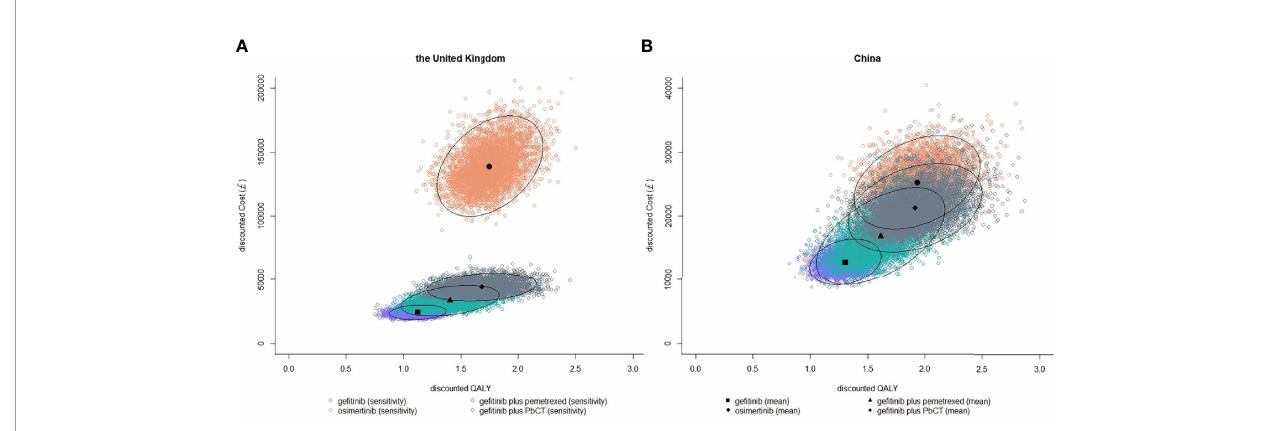
FIGURE 3 | Probabilistic scatter plots of costs and QLAYs of ge fi tinib, ge fi tinib plus pemetrexed based chemotherapy, and osimertinib for a cohort of 5000 in the UK (A) and the Chinese setting (B) . Ellipses surround 95% of